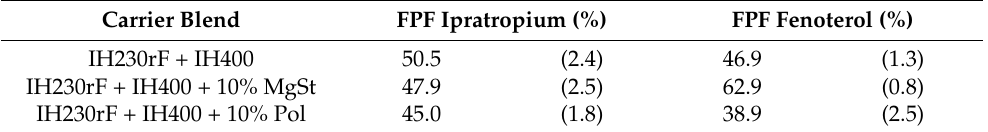
Table 2. FPF at a 5 µ m cut-off for ternary blends containing engineered fines. “IH400” herewith means that the fines are based on the processed IH400 quality, if stated, with the respective additive. n = 3, standard deviation in parentheses.